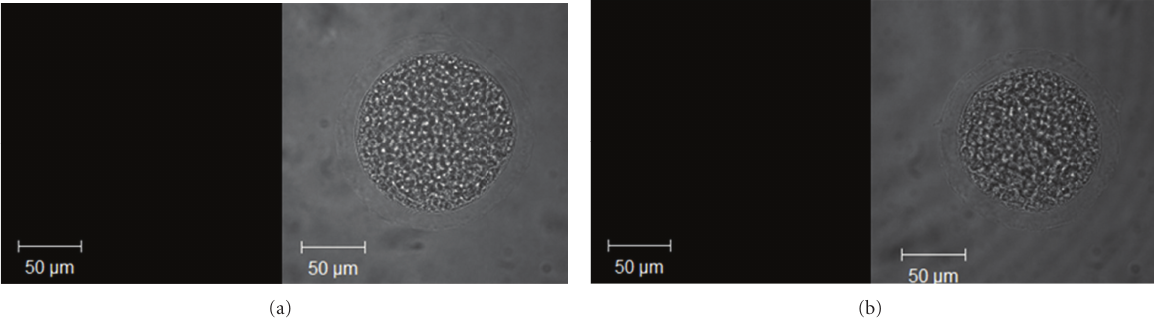
Figure 4: Confocal microscopic observation of control oocytes. Porcine oocytes with intact zona pellucida (negative control) were incubated for 1 h at room temperature with fluorescein isothiocyanate (FITC)-conjugated anti-goat IgG Ab produced in rabbits for INHA, diluted 1:200 in PBS/0.1% Tween 20 (a), and for INHB with TRITC (crystalline tetramethylrhodamine isothiocyanate)-conjugated anti-rabbit IgG Ab produced in goats, at a 1:200 in PBS/0.1% Tween 20 (b). The oocytes were mounted on glass slides in an antifade drop and observed under confocal system. Bars are 50 μ